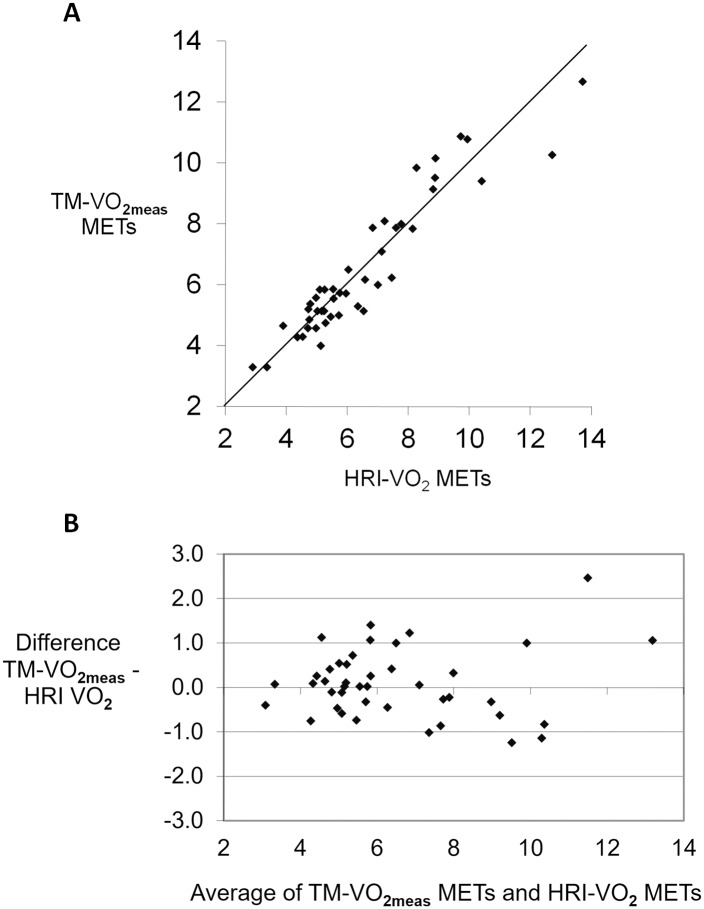
Line of identity and Bland Altman plot for TM-VO2meas.A. Line of identity for TM-VO2meas and B. against Bland Altman plot for TM-VO2meas against HRI-VO2.